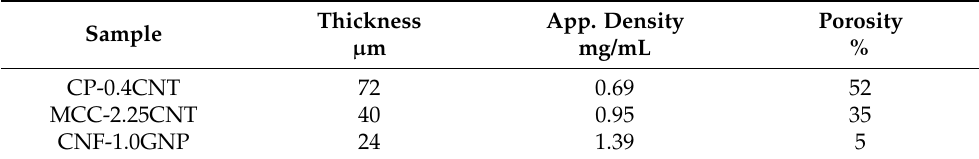
Figure 3. Digital photographs of nanocomposite films. Images of MCC-1%CB ( a ), CP-0.05%CNT ( b ), CNF-1%CB ( c ) and MCC-5%CNT ( d ).